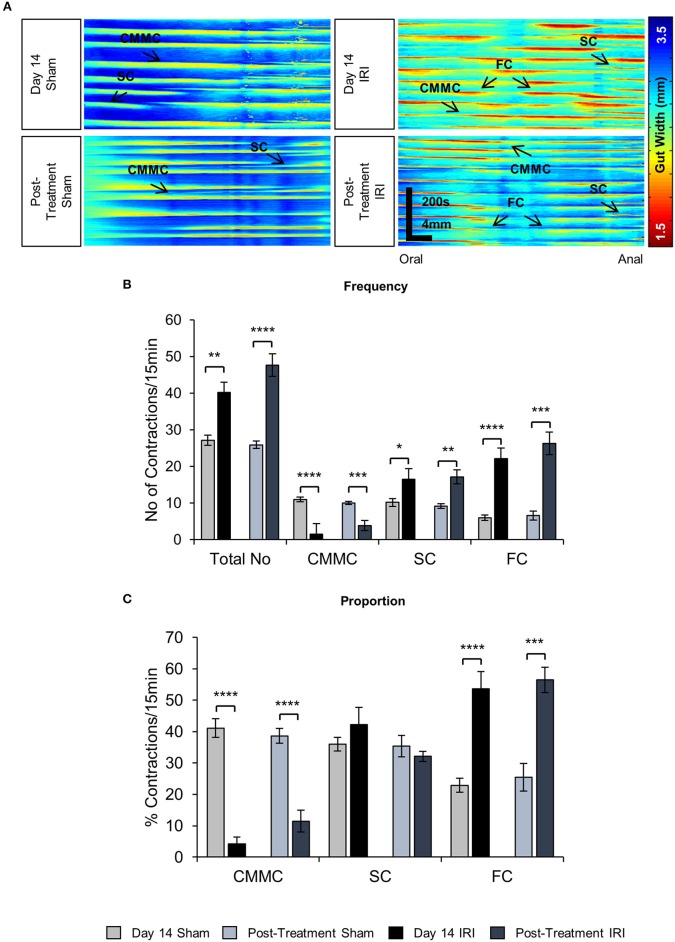
Effects of in vivo IRI treatment on the colonic motility. (A) Representative spatiotemporal maps generated from digital video recordings of colonic motility from sham and IRI-treated mice. Each contraction can be seen as a reduction in the gut width (red/yellow), while relaxation as an increase in the gut width (blue/green). Colonic migrating motor complexes (CMMCs) propagate >50% of the colon length, short contractions (SCs) propagate <50% of the colon length and fragmented contractions (FCs) are interrupted by period(s) of relaxation during contraction. (B) Frequency of contractions including all types of contractile activity and frequency of specific types of contractions in the colons from sham and IRI-treated mice. (C) The proportion of CMMCs, SCs and FCs to the total number of contractions. Gray columns: sham-treated, black columns: IRI-treated. Data presented as mean ± S.E.M. *P < 0.05, **P < 0.01, ***P < 0.001, ****P < 0.0001, compared to day 14 sham, n = 5 mice/group.